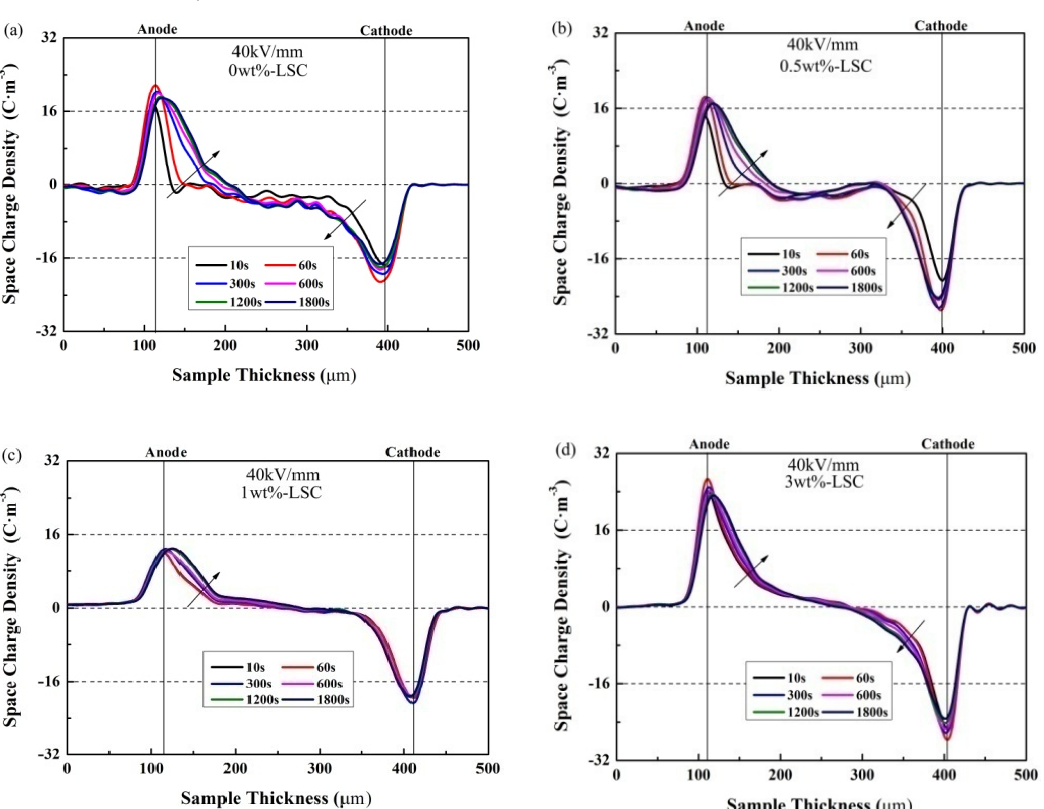
Figure 13. Space charge distribution of LDPE when the composite with different LSC contents acts as a semiconductive layer under 40 kV/mm DC electric field.